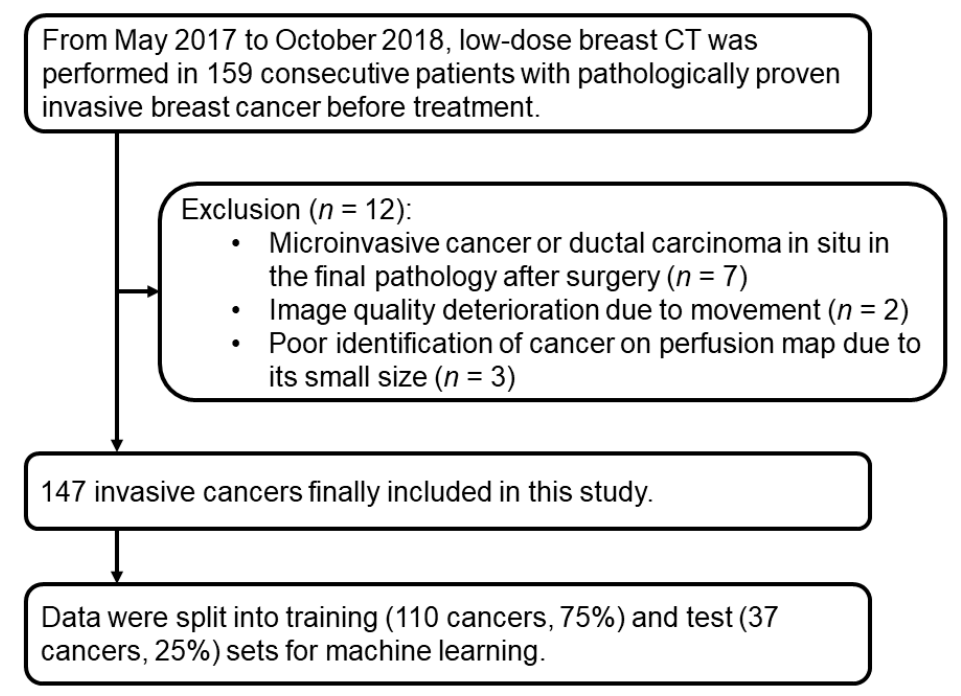
Figure 1. Flowchart of study population.